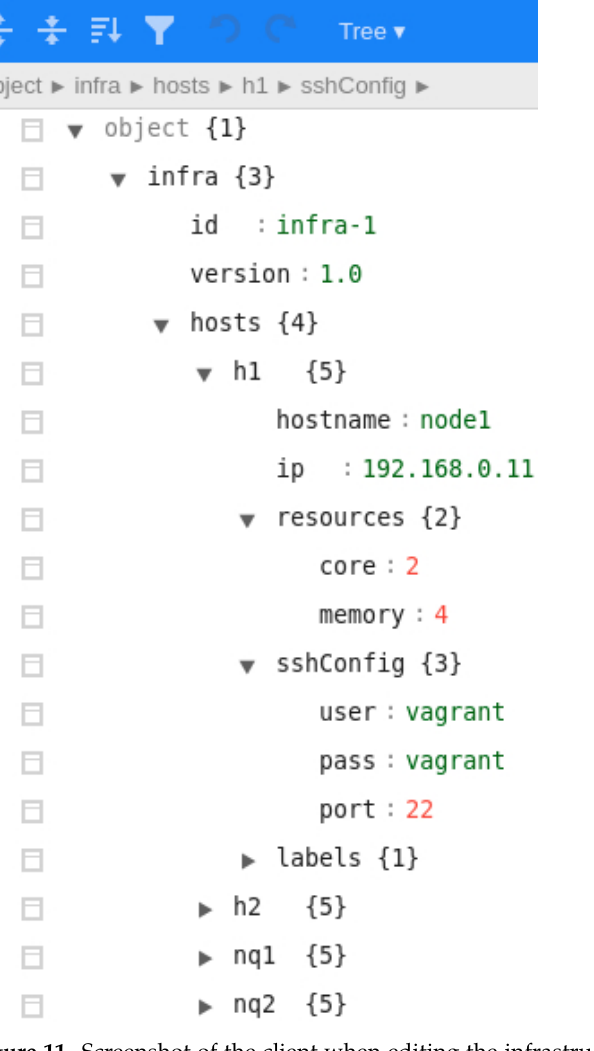
Figure 11. Screenshot of the client when editing the infrastructure definition. An example of the required properties of each node is